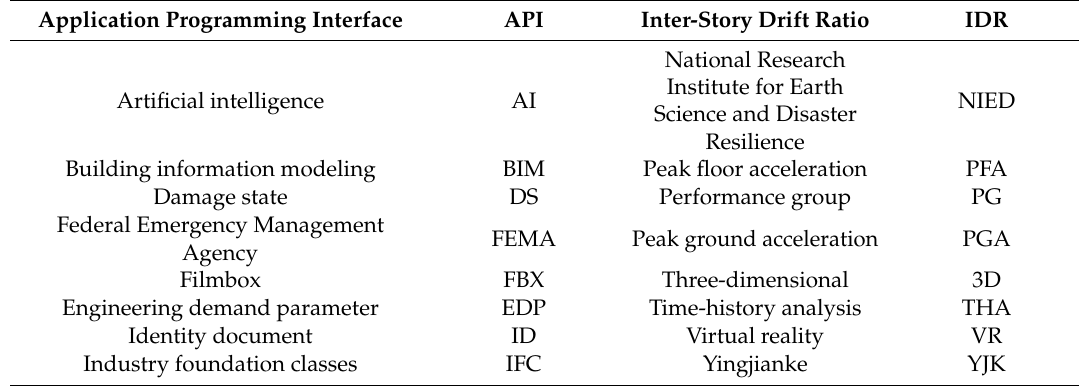
Table A1. Nomenclature and